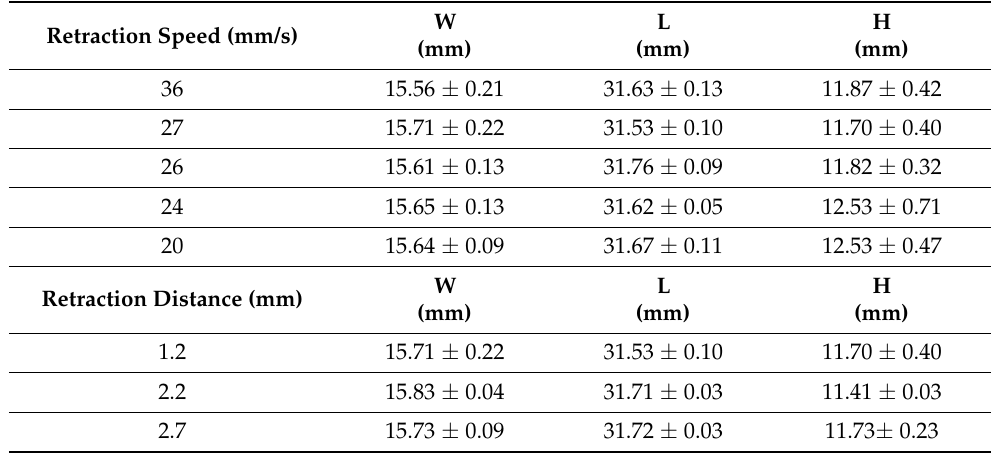
Table 5. Average size and standard deviation value (on di8 points) of Lego-type bricks as a function of changes in retraction speed and